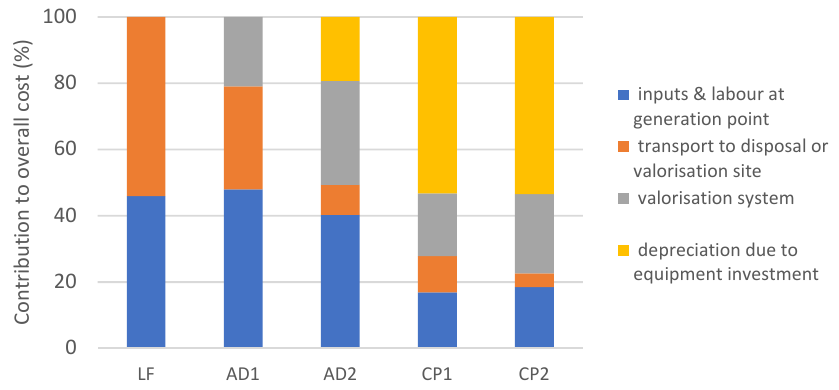
Figure 11. Contribution from each operation stage per FW treatment in the Land-Use impact category.